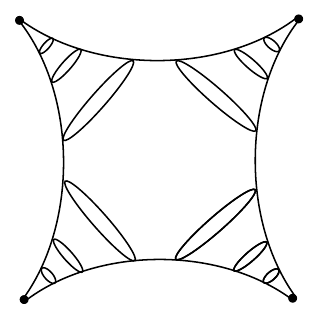
Figure 5. The SYK bilinear four-point planar diagram with no exchanged